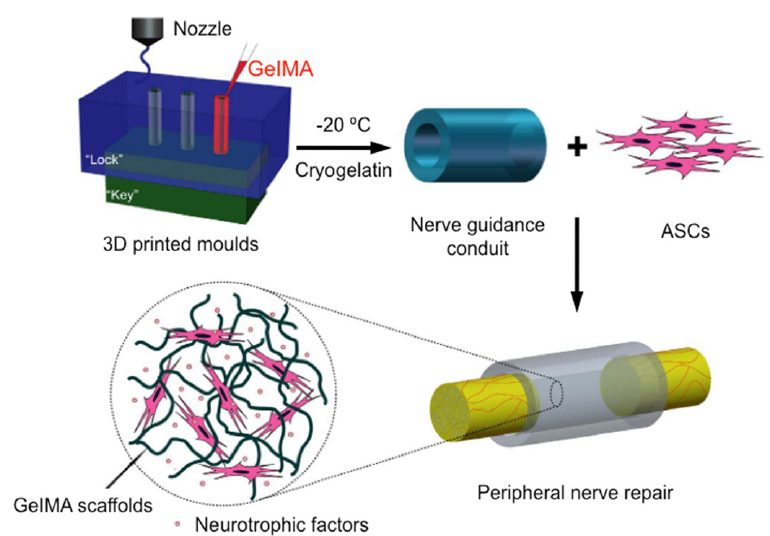
Figure 4. Schematic presentation of the 3D engineered bio-conduit for peripheral nerve regeneration. Adapted with permission from ref. [33]. Copyright 2016, Nature Publishing Group.